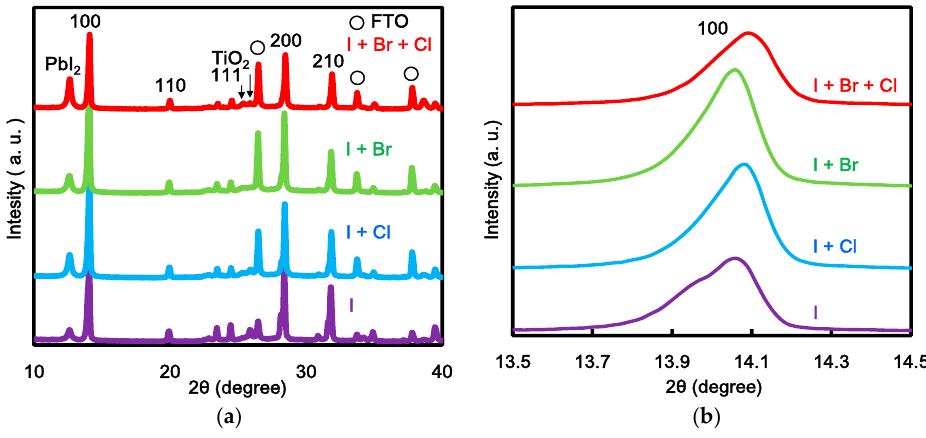
Figure 5. X ‐ ray diffraction patterns (XRDs) of FTO/TiO 2 /CH 3 NH 3 PbI 3 − x − y Br x Cl y cells: ( a ) 10° < 2 θ < 40°; Figure 5. X-ray diffraction patterns (XRDs) of FTO/TiO 2 /CH 3 NH 3 PbI 3 ´ x ´ y Br x Cl y cells: ( a ) 10 ˝ < 2 θ < 40 ˝ ; and ( b ) 13.5° < 2 θ < 14.5°. and ( b ) 13.5 ˝ < 2 θ < 14.5 ˝